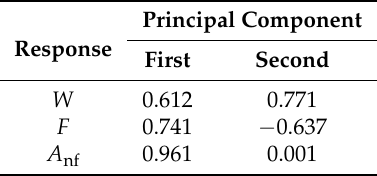
Table 8. Results of principal component load coefficients.